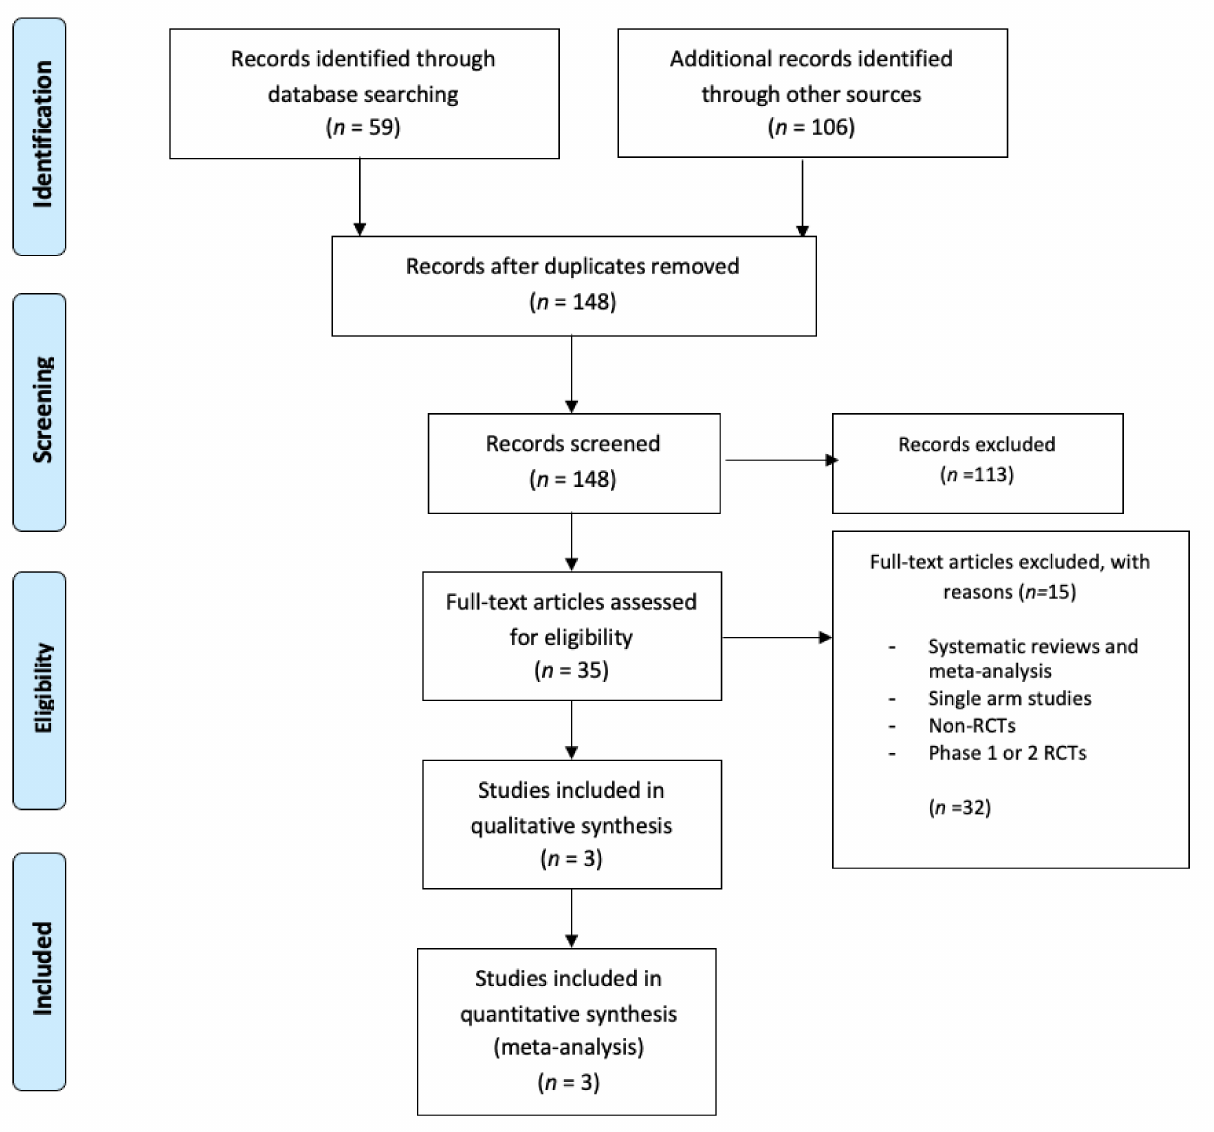
Figure 1. PRISMA